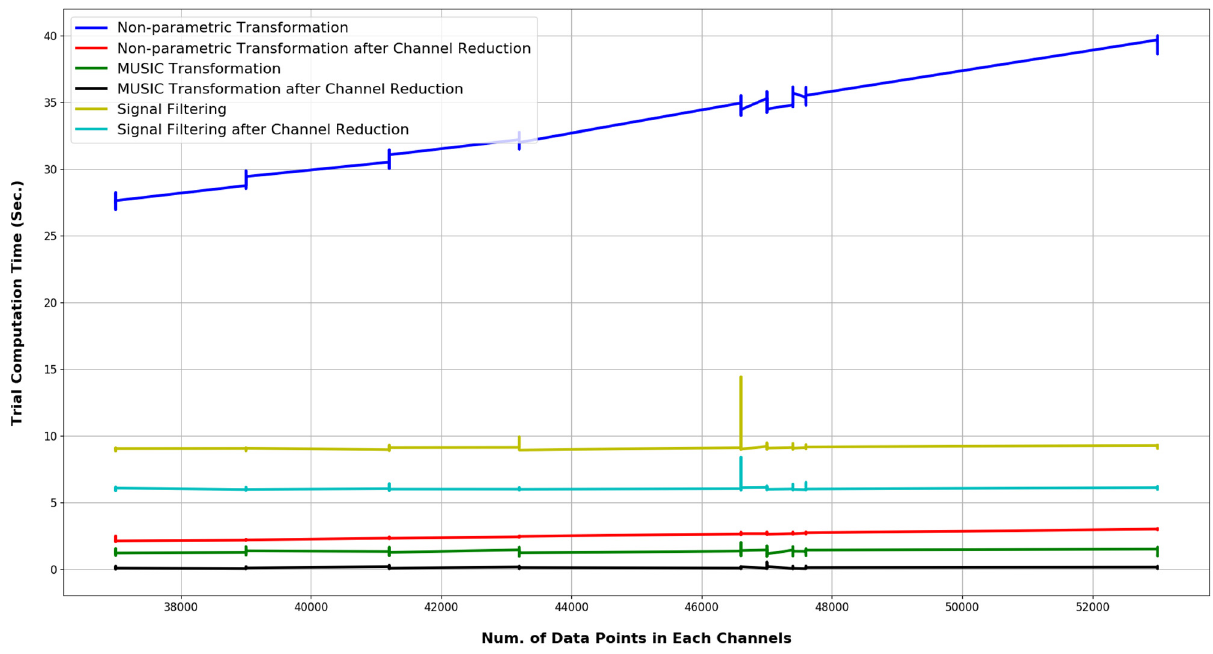
Figure 16. Run time comparison of various methods for multi-channel EEG pre-processing and feature-extraction tasks.